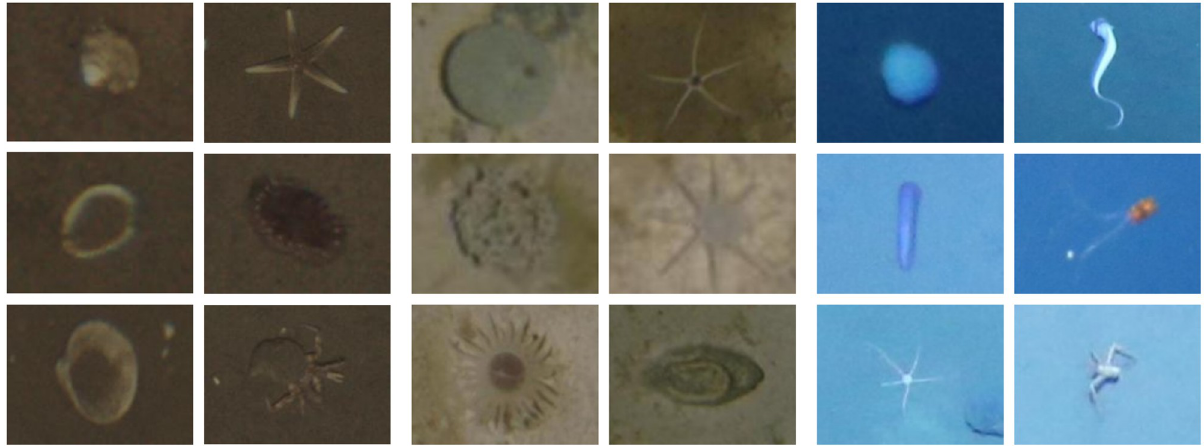
Fig 2. Examples of frequent OOI in the JC77 (columns 1-2), PAP (columns 3-4) and SO242 (columns 5-6) datasets.